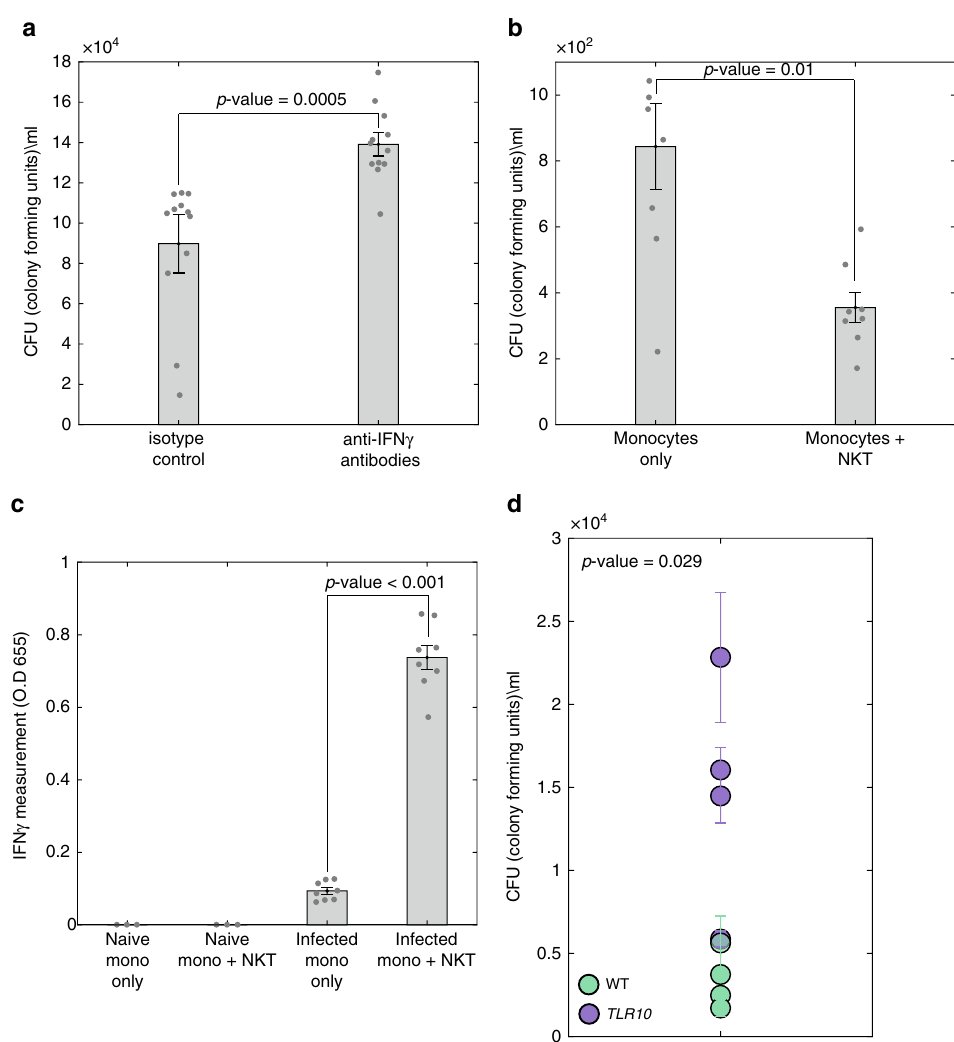
Fig. 5 Differences in cell – cell signaling is associated with different bacterial control in WT and TLR10 individuals. a Isolated PBMCs from a WT individual were infected ex vivo with Salmonella in the presence of isotype control or anti-IFN γ neutralizing antibodies. Intracellular bacterial growth was determined by CFU 8 h post-infection. Data are presented as bar chart with the average of three independent experiments with four replicates and SEM, all data points are presented by dots. Blocking IFN γ in WT individual increases bacterial load; statistical signi fi cance was determined using Friedman ’ s test, p -value is indicated. b Intracellular bacteria number was determined by CFU 8 h after ex vivo Salmonella infection of monocytes alone or co-culture of monocytes and NKT cells. Data are presented as bar chart with mean and SEM of eight replicates; data points are presented by dots. Co-culture of monocytes with NKT cells provided better control of intracellular bacterial infection relative to monocytes alone; statistical signi fi cance was determined using the unpaired Mann – Whitney U test, p -value is indicated in the fi gure. c Secreted IFN γ levels from monocytes alone or co-culture of monocytes and NKT cells were measured before and after ex vivo Salmonella infection. Data are presented as bar chart with mean and SEM of eight replicates; data points are presented by dots. Co-culture of monocytes and NKT cells secreted signi fi cantly higher levels of IFN γ relative to monocytes alone; statistical signi fi cance was determined using the unpaired Mann – Whitney U test, p -value is indicated. d Isolated PBMCs from eight individuals (WT in green and TLR10 in purple) were infected ex vivo with Salmonella . Intracellular bacterial growth was determined by CFU 8 h post-infection. Data are presented as mean and SEM of three replicates. TLR10 individuals exhibit higher bacterial load than WT individuals; statistical signi fi cance was determined using the